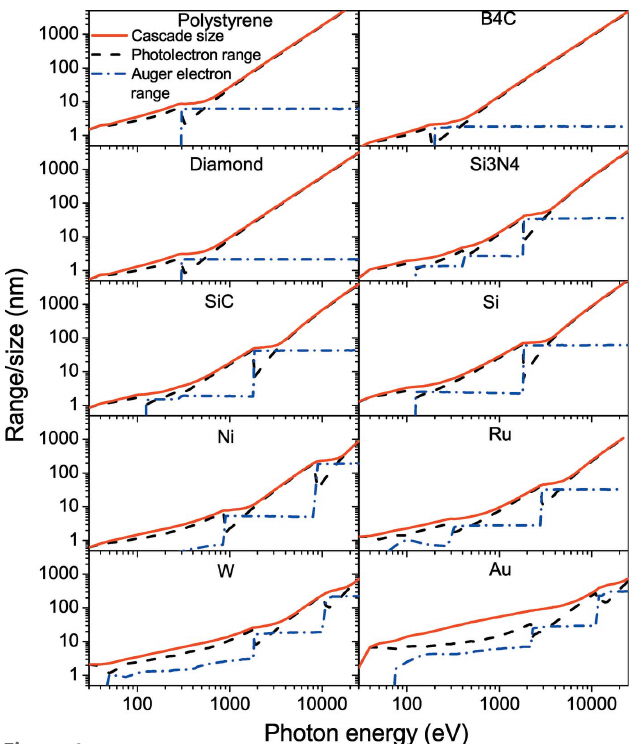
Figure 6 Sizes of the cascades induced by a photon of given energy in various materials, compared with the photo- and Auger-electron ranges. Targets are arranged by increase of the average atomic number.